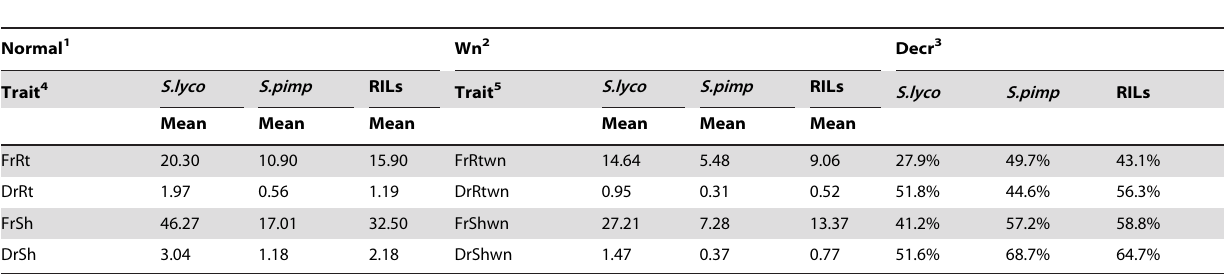
empty regions across the 12 chromosomes can be seen (Fig. 3). Co- localization of QTLs was found for different seed and seedling traits on the bottom of chromosomes 1, 4, 6, 9 and 11 (Table 3, Fig. 3). Out of the 62 detected QTLs, 25 were related to seed traits, such as seed weight, seed size, seed length and seed circularity. Seventeen QTLs were related to seedlings biomass, such as fresh and dry root and shoot weight (across both the Table 2. Reduction in biomass of seedling grown under nutrient stress condition as compared to the biomass obtained under normal nutrient conditions.